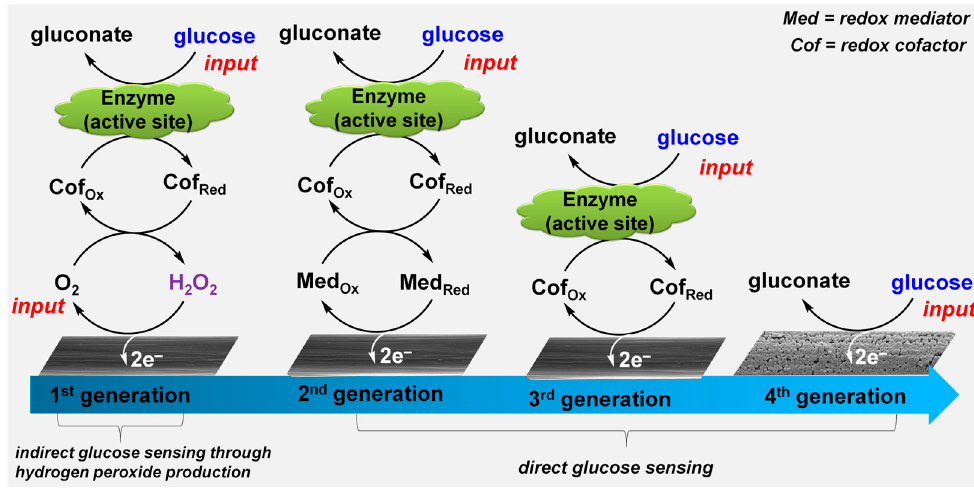
Figure 1. Summary of glucose electrooxidation mechanisms: presented as enzymatic (first ‐ , second ‐ and third ‐ generation sensors) and non ‐ enzymatic (so ‐ called herein “fourth ‐ generation” sensors).